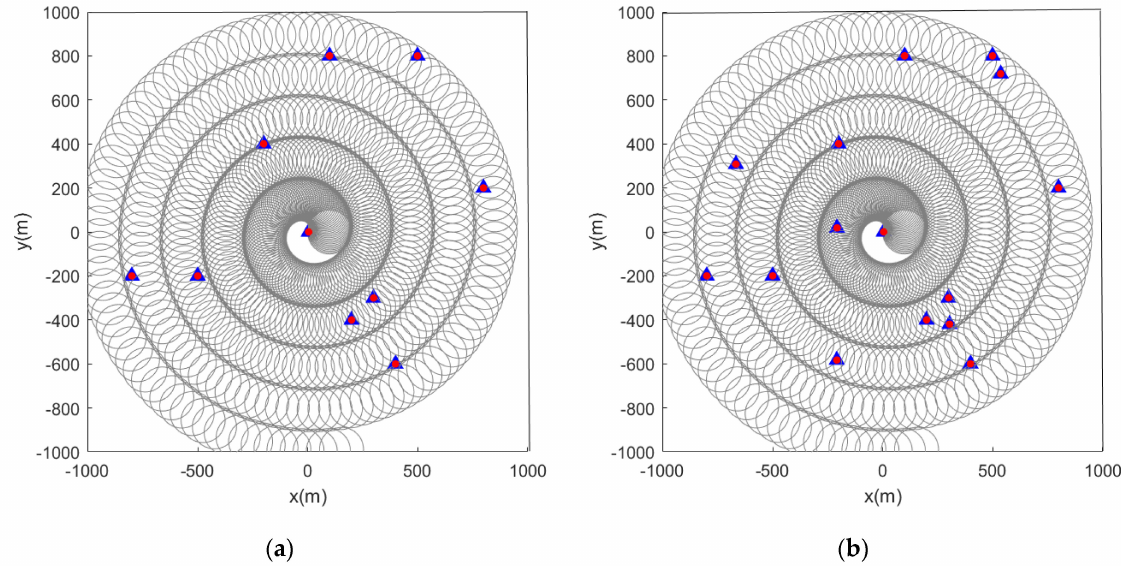
Figure 11. Estimated position of stationary feature points using the GLMB algorithm (the red and blue marks indicate the true and estimated positions, respectively, of the feature points in the scene). ( a ) Sensor detection radius is 100 m and there are 10 feature points in the scene; ( b ) sensor detection radius is 100 m and there are 15 feature points in the